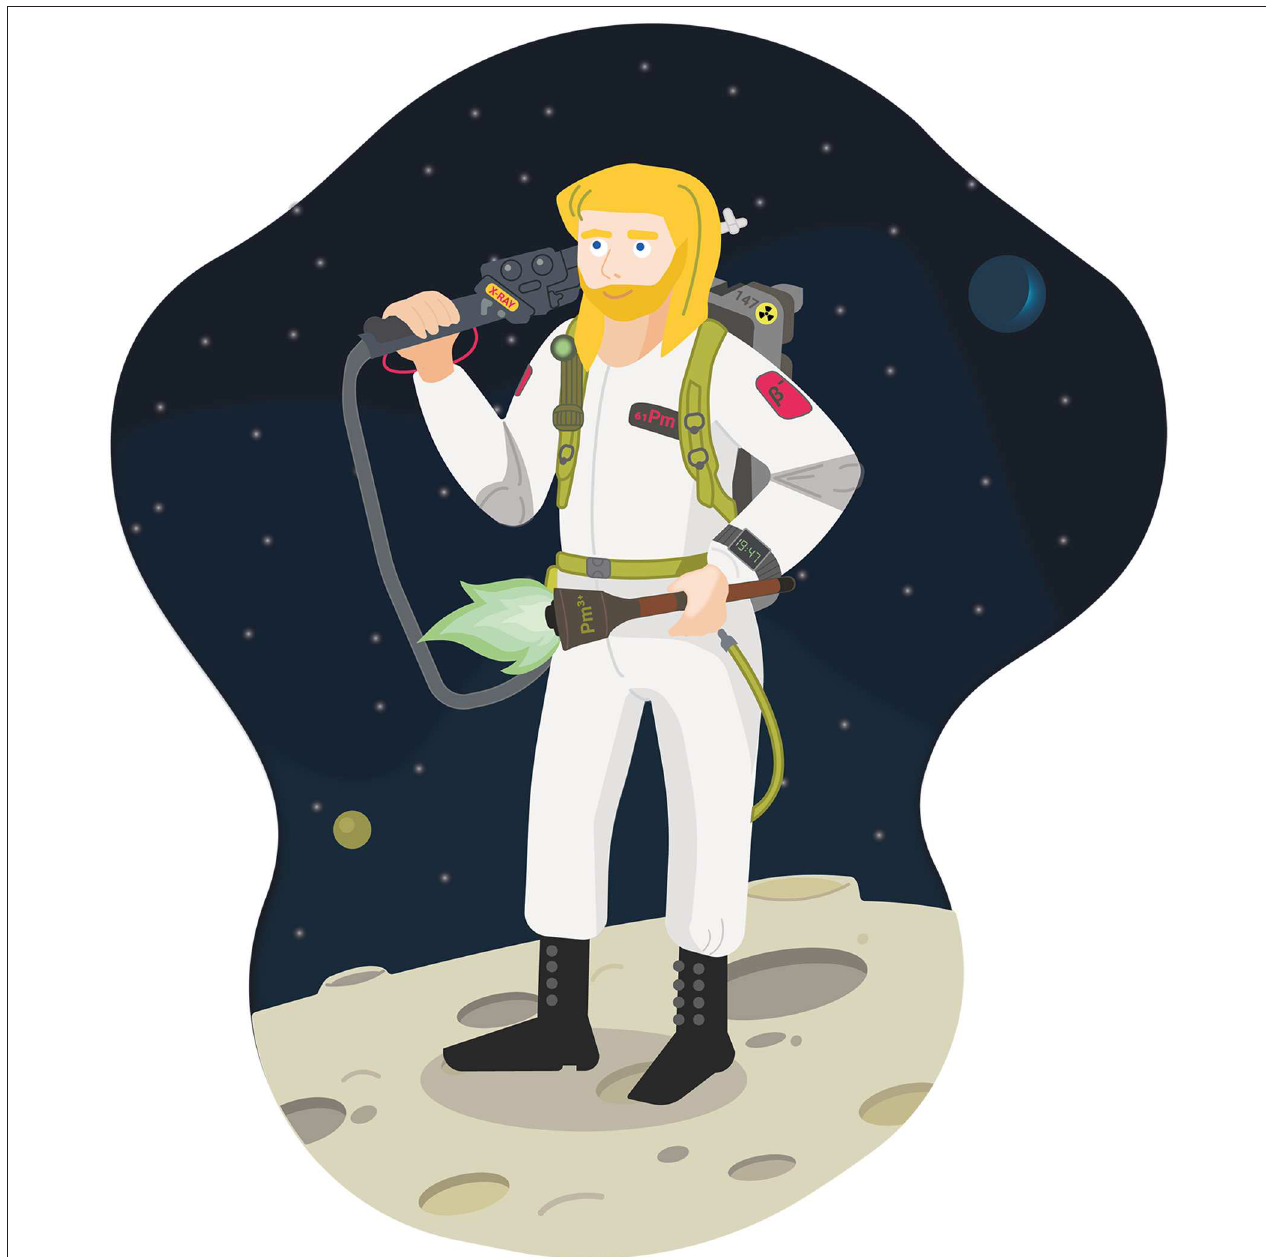
at Clinton Laboratories (TN, USA). The thermal neutron- induced fission of 235 U has a 147 Pm cumulative yield (CY) of 2.25% (England and Rider, 1994). This means for every 100 fissions of 235 U, there are 2.25 atoms of 147 Pm produced. The 149 Pm CY for thermal neutron-induced fission of 235 U is only 1.08%. Ion-exchange chromatography was